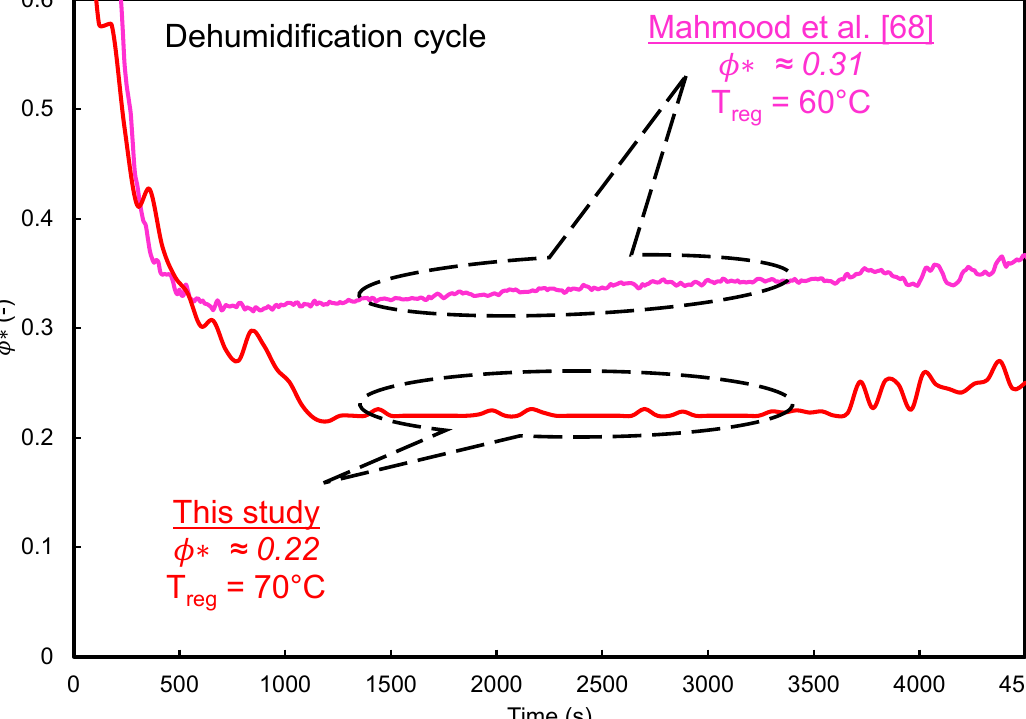
Figure 7. Experimental evaluation of the slope of the dehumidification line at di ff erent regeneration temperatures.